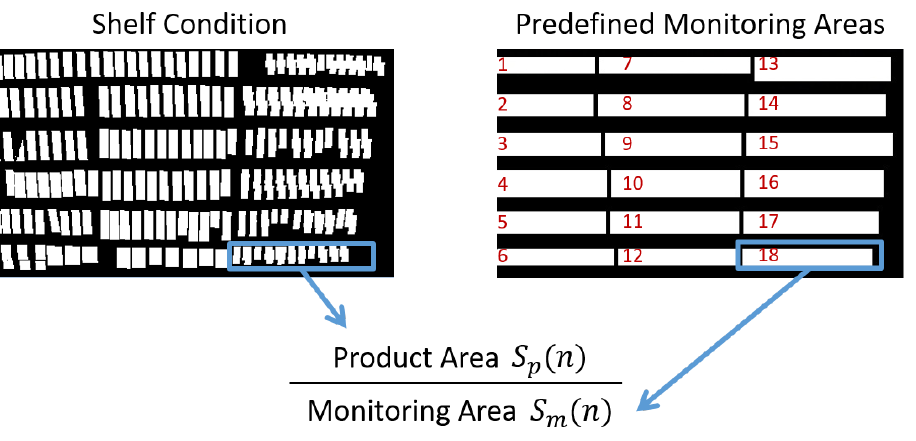
Figure 11. Overview of computing on-shelf availability for n th